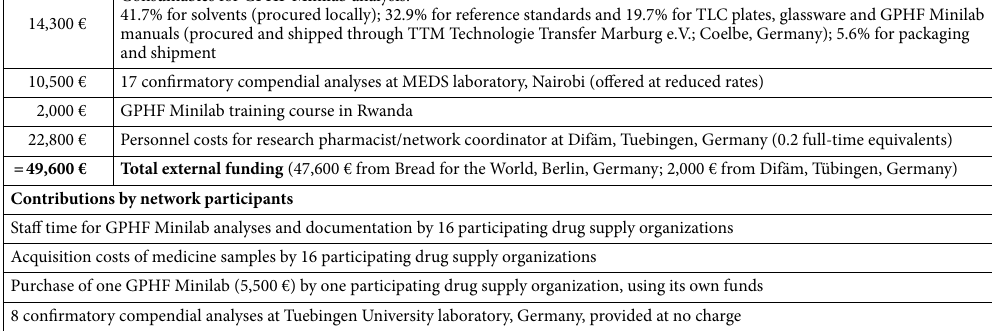
Table 3. Funding requirements for the surveillance for substandard and falsified medicines in the reporting period (Jan. 2019–Dec.